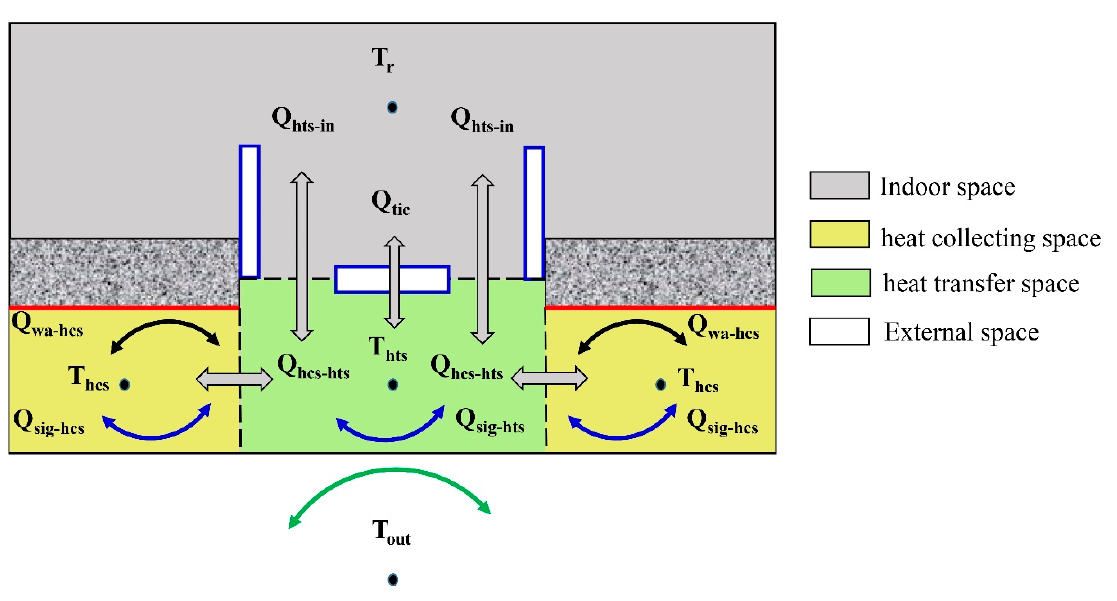
Figure 2. Heat transfer processes of HHCF.